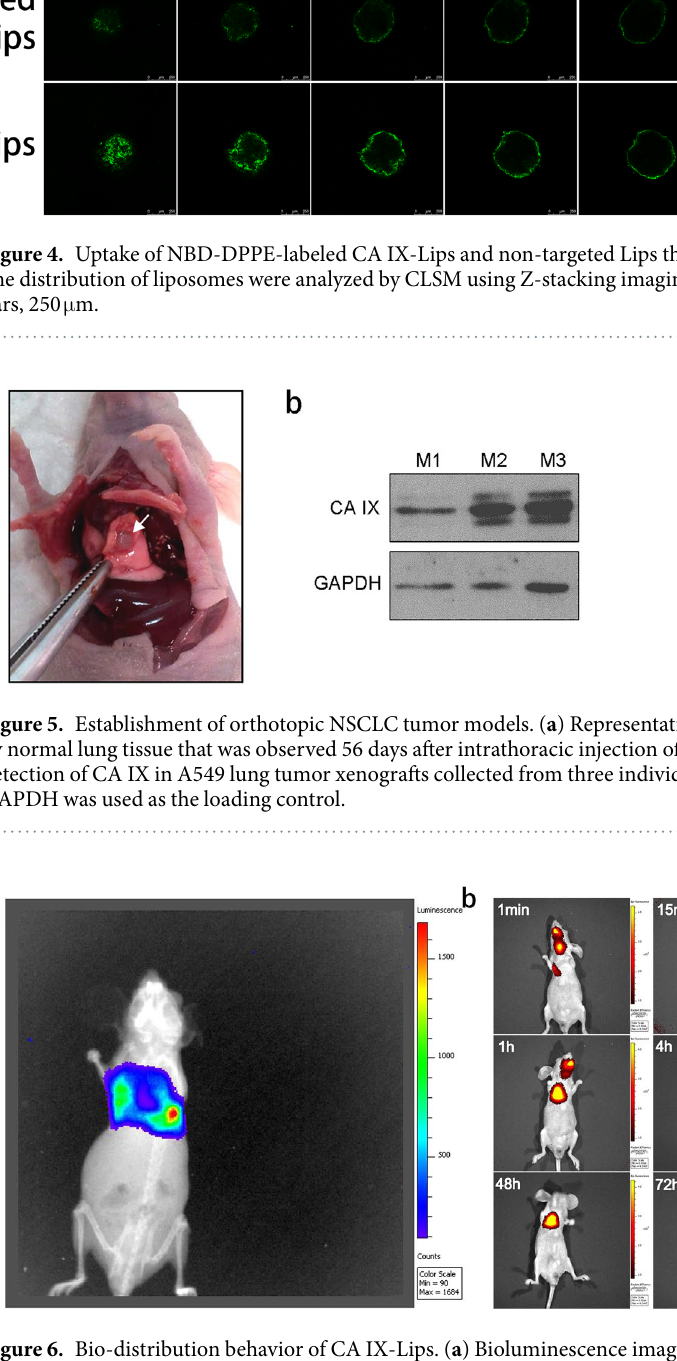
Figure 6. Bio-distribution behavior of CA IX-Lips. ( a ) Bioluminescence imaging of A549-Luc orthotopic tumor-bearing mouse; ( b ) Fluorescence imaging of CA IX-decorated DiR liposomes bio-distribution behavior in A549-Luc orthotopic tumor-bearing mouse at different time points after endotracheal